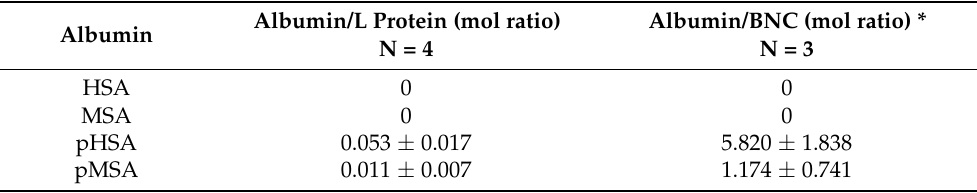
Table 2. QCM analysis of interactions between albumins and BNCs.